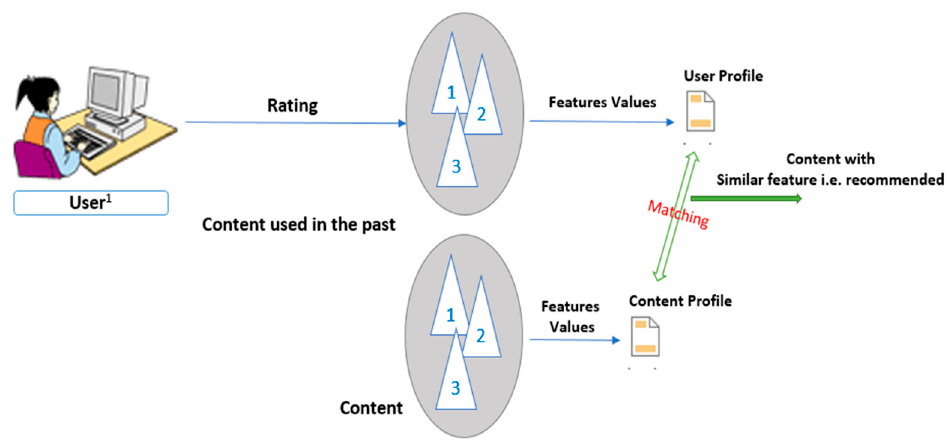
Figure 3. Content-based filtering